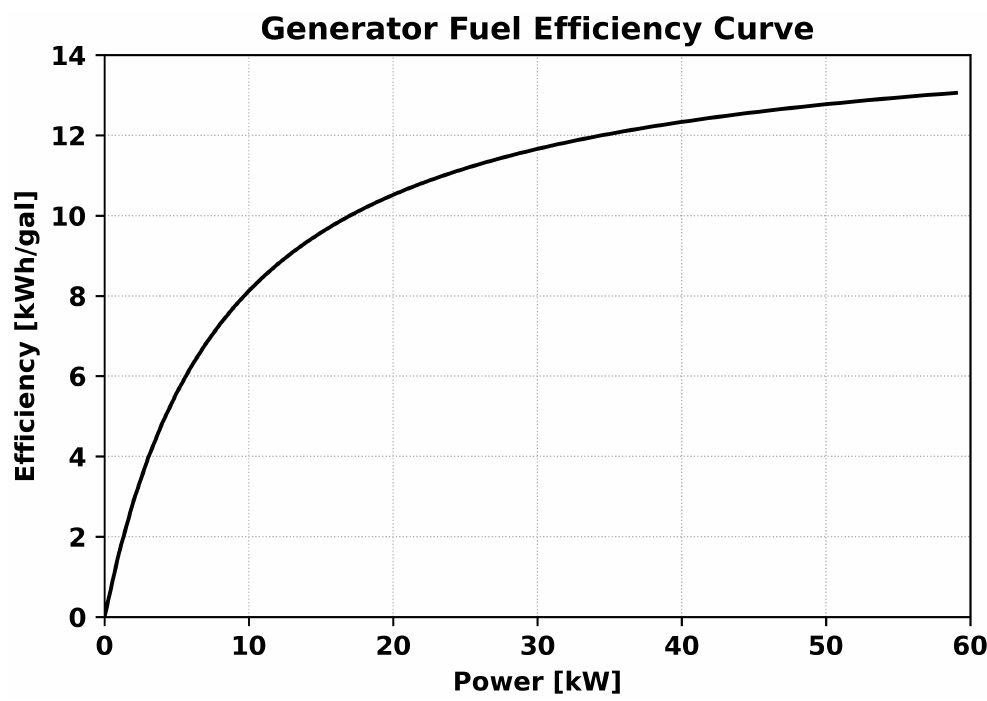
Figure 4. Fuel efficiency curve of a 60 kW AMMPS generator based on generator steady-state power output